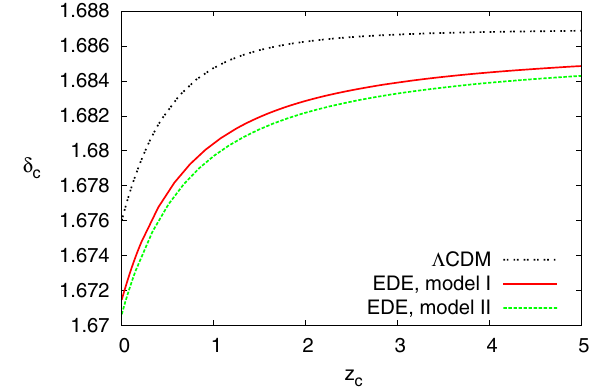
Fig. 8 Extrapolated linear density contrast at collapse δ c versus collapse redshift z c for EDE models I (solid, red) and II (long-dashed, green), as well as Λ CDM (double-dashed, black). Image reproduced by permission from Wintergerst and Pettorino (2010); copyright by